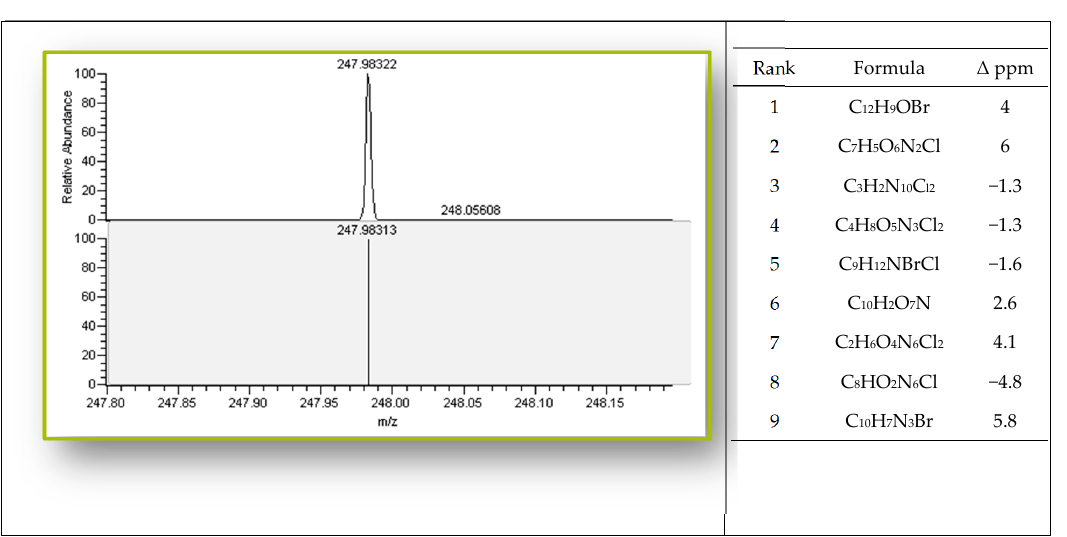
Figure 3. The importance of high mass accuracy: The high mass accuracy allows researchers to limit the number of possible molecular formulae significantly based on the accurate mass measurement. Here the correct formula, C 12 H 9 OBr (1-bromo-4-phenoxy-benzene), is the highest ranked formula based on lowest mass error. While other molecular formulas are possible they can be excluded when combined with knowledge of the target ion. Used with permission from Thermo Scientific; Waltham, MA, USA.